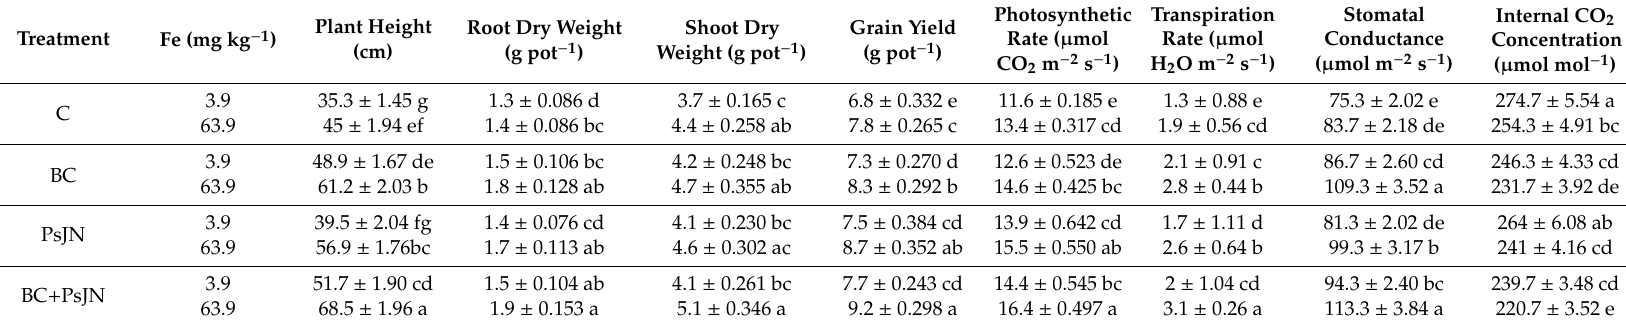
Table 1. The e ff ect of biochar- Burkholderia phytofirmans PsJN integration on growth and physiological parameters of Chenopodium quinoa under salinity stress.